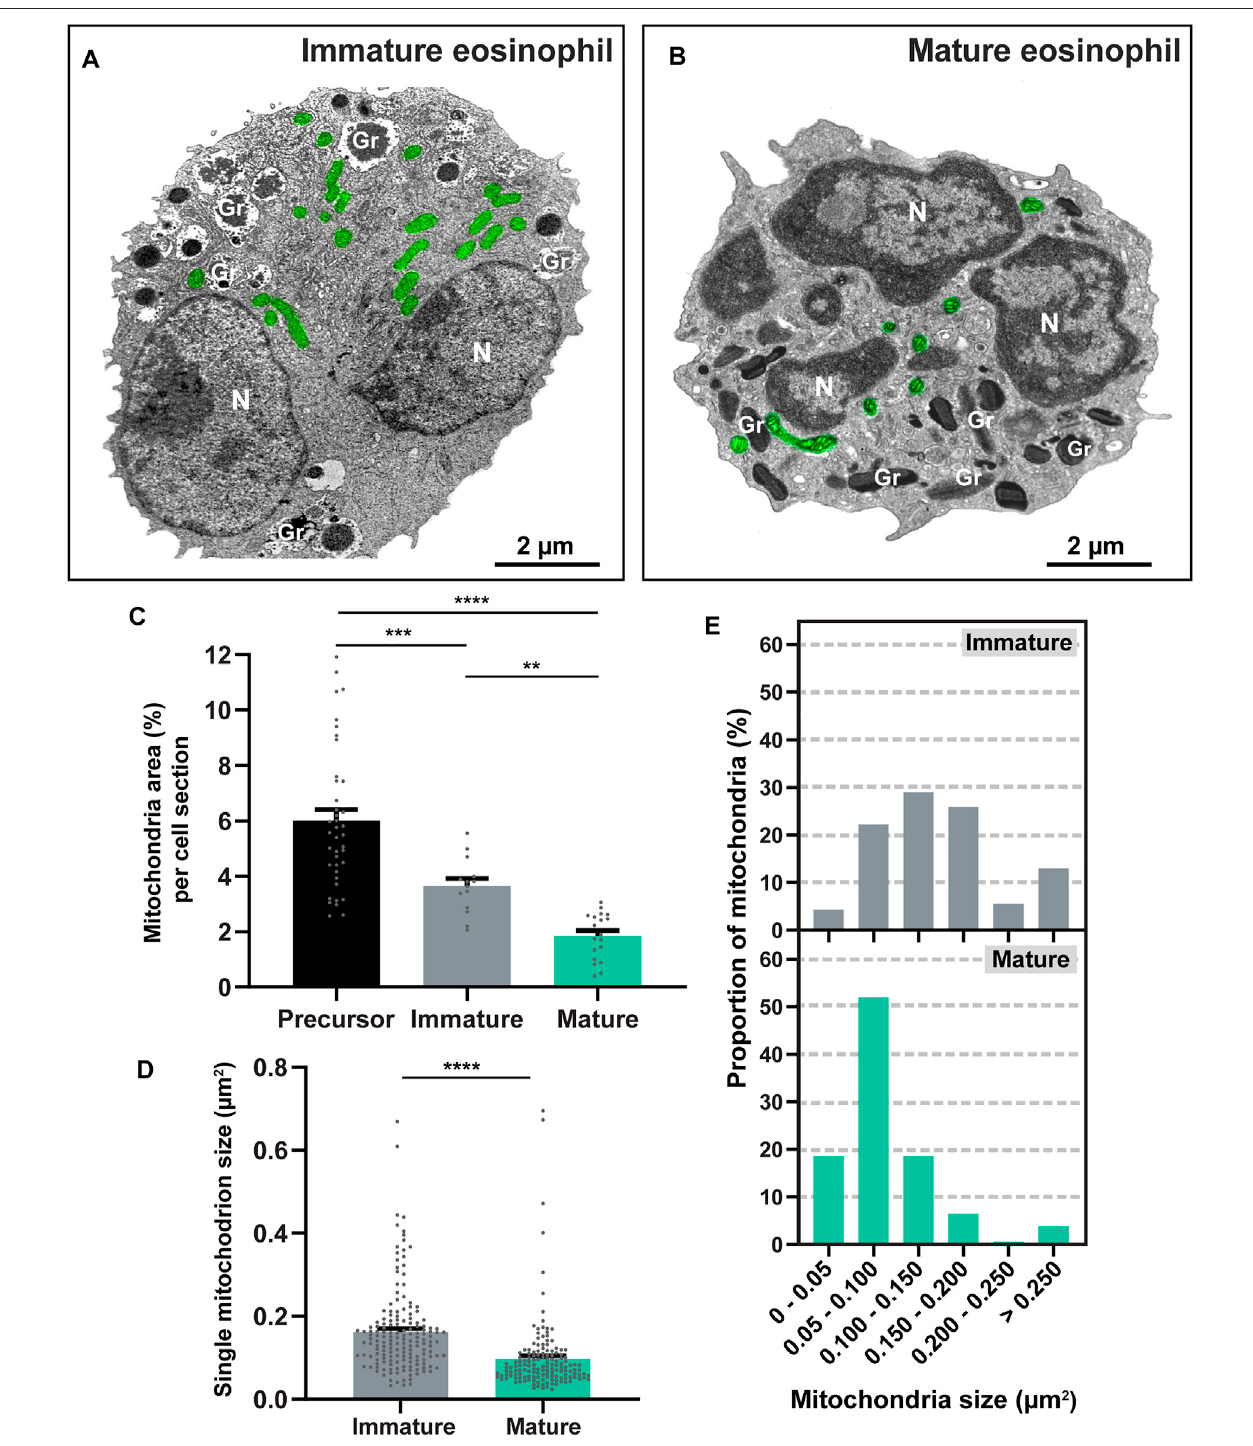
FIGURE 2 | Mouse eosinophilmaturation leads to the reduction of mitochondrial population. (A,B) Electron micrographs of a representative immature and mature eosinophil observed in a BMdEos culture. In the immature eosinophil, note round immature speci fi c granules (Gr) in process of content fi lling and a nucleus (N), already segmented but still in process of chromatin condensation. In the mature eosinophil, speci fi c granules (Gr) are elongated with typical internal crystalloid and nucleus (N) exhibit clear euchromatin-heterochromatin distinction. Note the mitochondrial population (pseudocolored green). (C – E) The mitochondrial area in the cytoplasm and the size of individual mitochondria signi fi cantly reduce during eosinophilopoiesis. Samples were prepared for TEM and quantitative analyses performed using Fiji software. A total of 925 mitochondria were evaluated at high resolution within 88 cells collected from at least three independent cell cultures. Scattered dots in (C,D) represent single mitochondria data. Results are expressed as means ± SEM (** p < 0.01; *** p < 0.001; **** p < 0.0001).